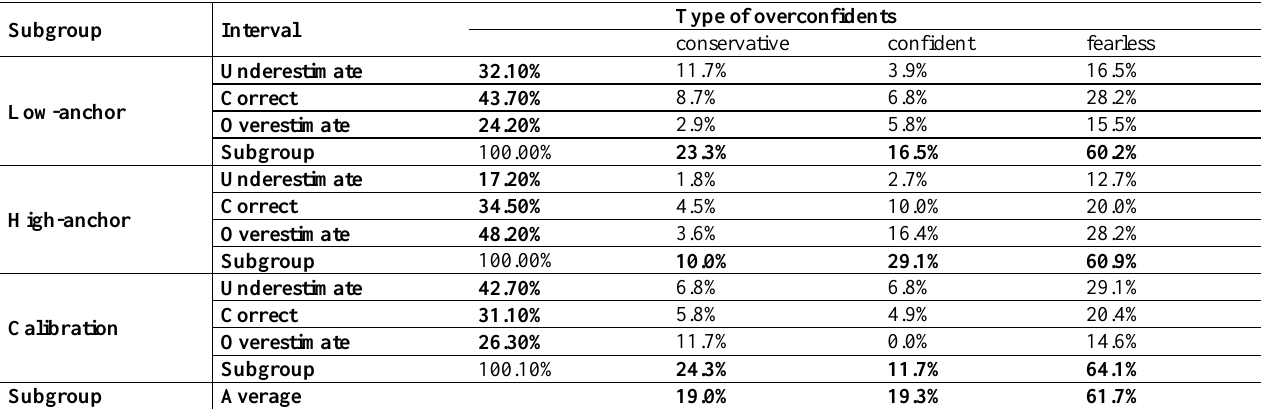
Type of overconfidents conservative confident fearless